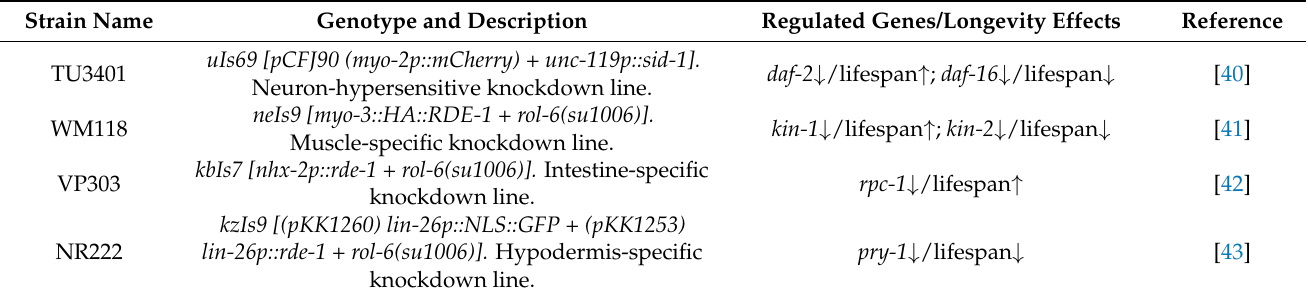
Table 1. Tissue-specific strain